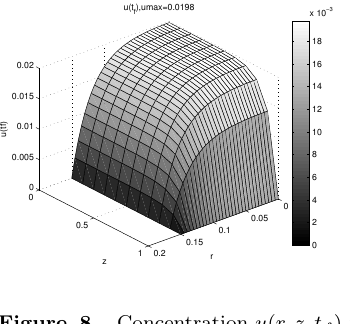
Figure 8. Concentration u ( r,z,t f ) for t f = 50